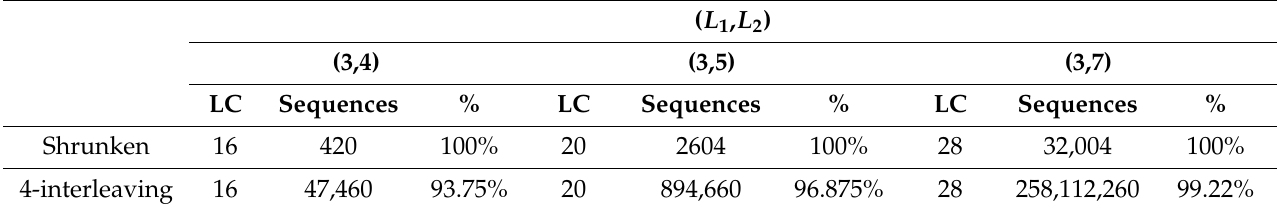
Table A4. Comparison between number of shrunken sequences and 4-interleaving sequences with maximum LC .